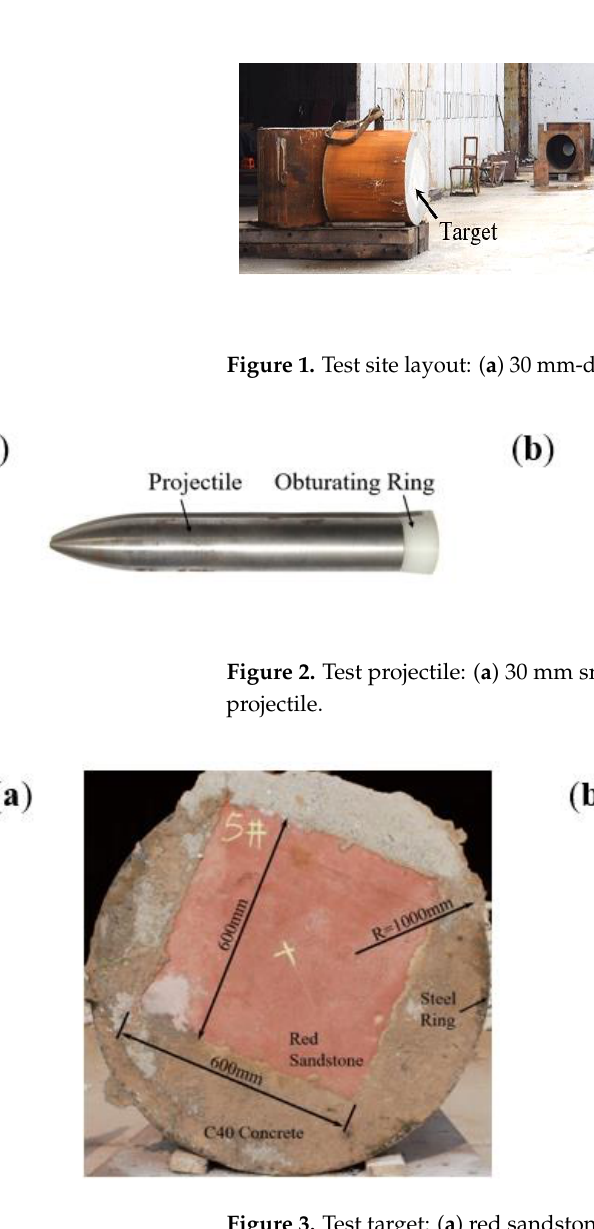
Figure 1. Test site layout: ( a ) 30 mm-diameter smoothbore gun; ( b ) 60 mm-diameter smoothbore gun.